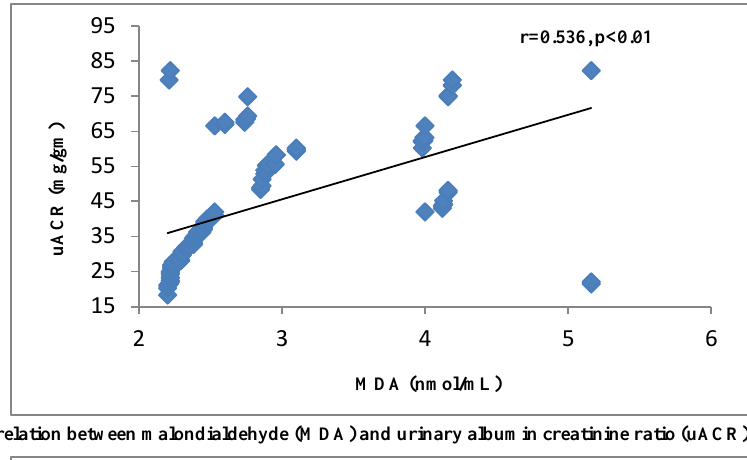
Fig. 1. Correlation between MDA and cystatin C in cigarette smokers.